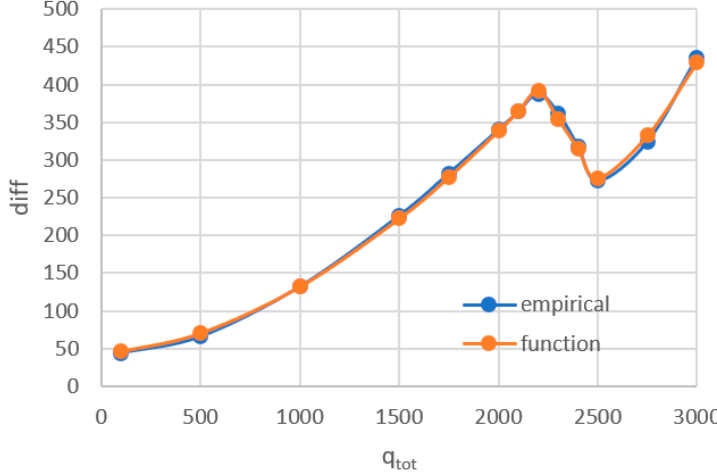
Figure 18. Fitting of the function, source: